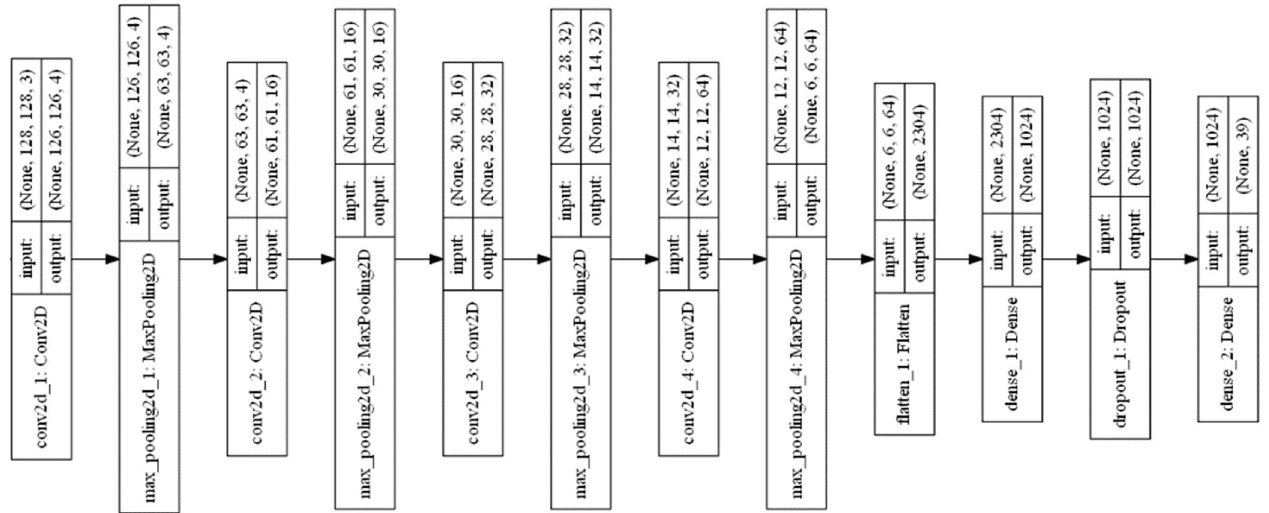
Table 3. Optimized hyperparameters of the Conv-4 DCNN. Hyperparameters